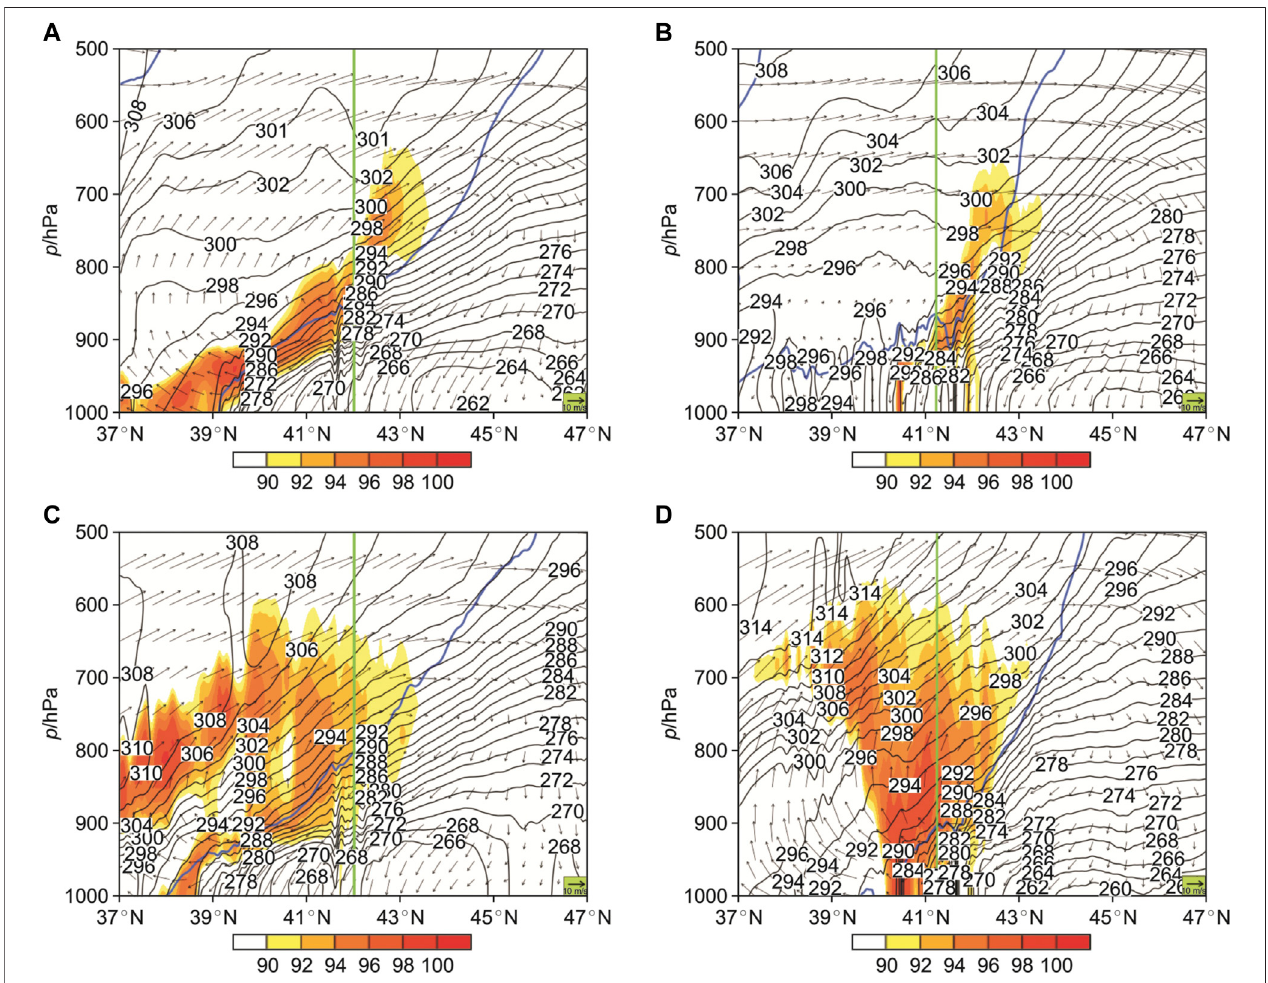
FIGURE 9 | Equivalent potential temperature ( θ se), relative humidity, and wind at the longitude positions of Zhangwu (A) , 1:00 on Day 1; (C) , 8:00 on Day 1 and Huanren (B) , 08:00 on Day 1; (D) , 1:00 on Day 2 stations (unit, temperature: K, relative humidity: %, and wind speed: m/s, green solid line: latitudes of Zhangwu and Huanren